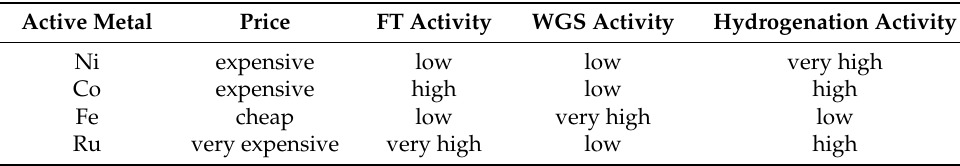
Table 4. Overview of main characteristics of Ni-, Fe-, Co- and Ru-based catalysts [49]. Active Metal Price FT Activity WGS Activity Hydrogenation Activity Ni expensive low low very high Co expensive